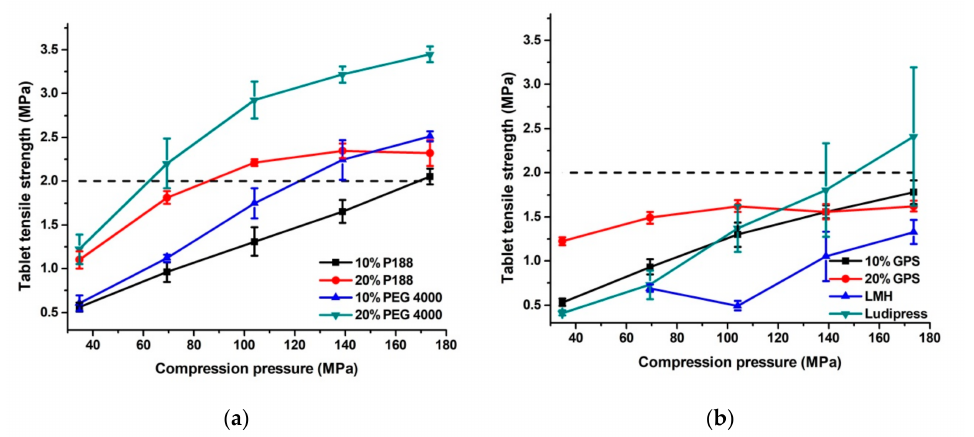
Figure 4. ( a , b ) Tabletability profiles of co-processed mixtures, LMH and Ludipress ®